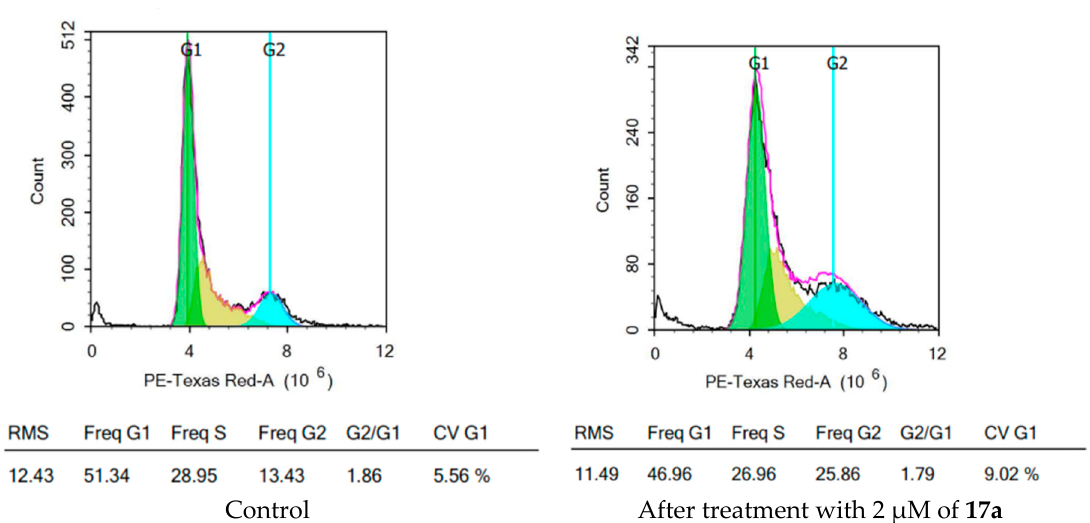
Figure 8 . HepG2 cell cycle analysis before and after treatment with 2 μ M of 17a . Figure 8. HepG2 cell cycle analysis before and after treatment with 2 µ M of 17a